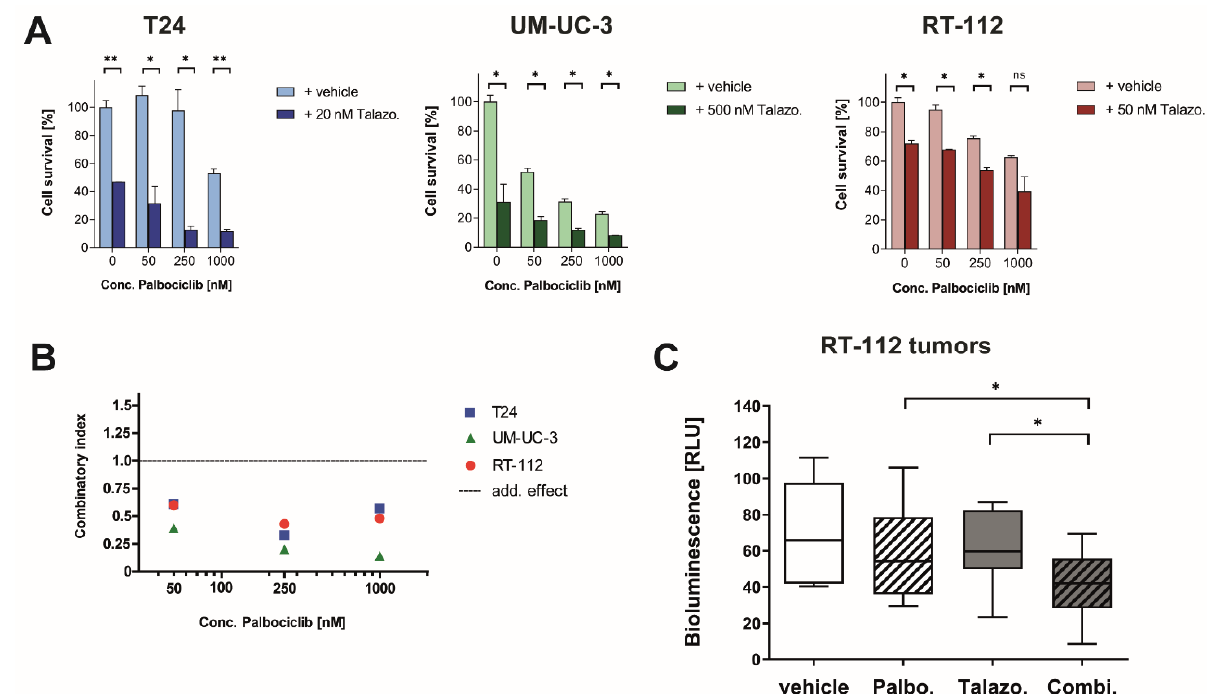
Figure 4. The addition of Talazoparib synergistically enhances the monotherapy of Palbociclib in BLCA models in vitro as well as in vivo. ( A ) Cell viability assay 5 days after treatment; data are representative of six independent experiments and are presented as mean ± SD of biological duplicates. ( B ) Quantification of synergism utilizing cell viability data. Combinatory indices (CI) were calculated using the Chou–Talalay method for drug combination; thereby indicating the following effects: antagonistic (CI > 1), additive (CI = 0), or synergistic (CI < 1). ( C ) CAM assay using a low dose of Talazoparib (50 nM) in combination with Palbociclib (1 µM) to determine in vivo effectivity against three-dimensionally grown RT-112 cells. Data are representative of three independent experiments and are presented as a box and whisker plot depicting minimum, median and maximum samples of n = 8 for the vehicle, Talazoparib, and combination, and n = 10 for Palbociclib-treated tumors. Statistical comparison was performed using t -test of GraphPad Prism V9 software, indicating respective p -values: ns: p > 0.05, *: p ≤ 0.05, and **: p ≤ 0.01.